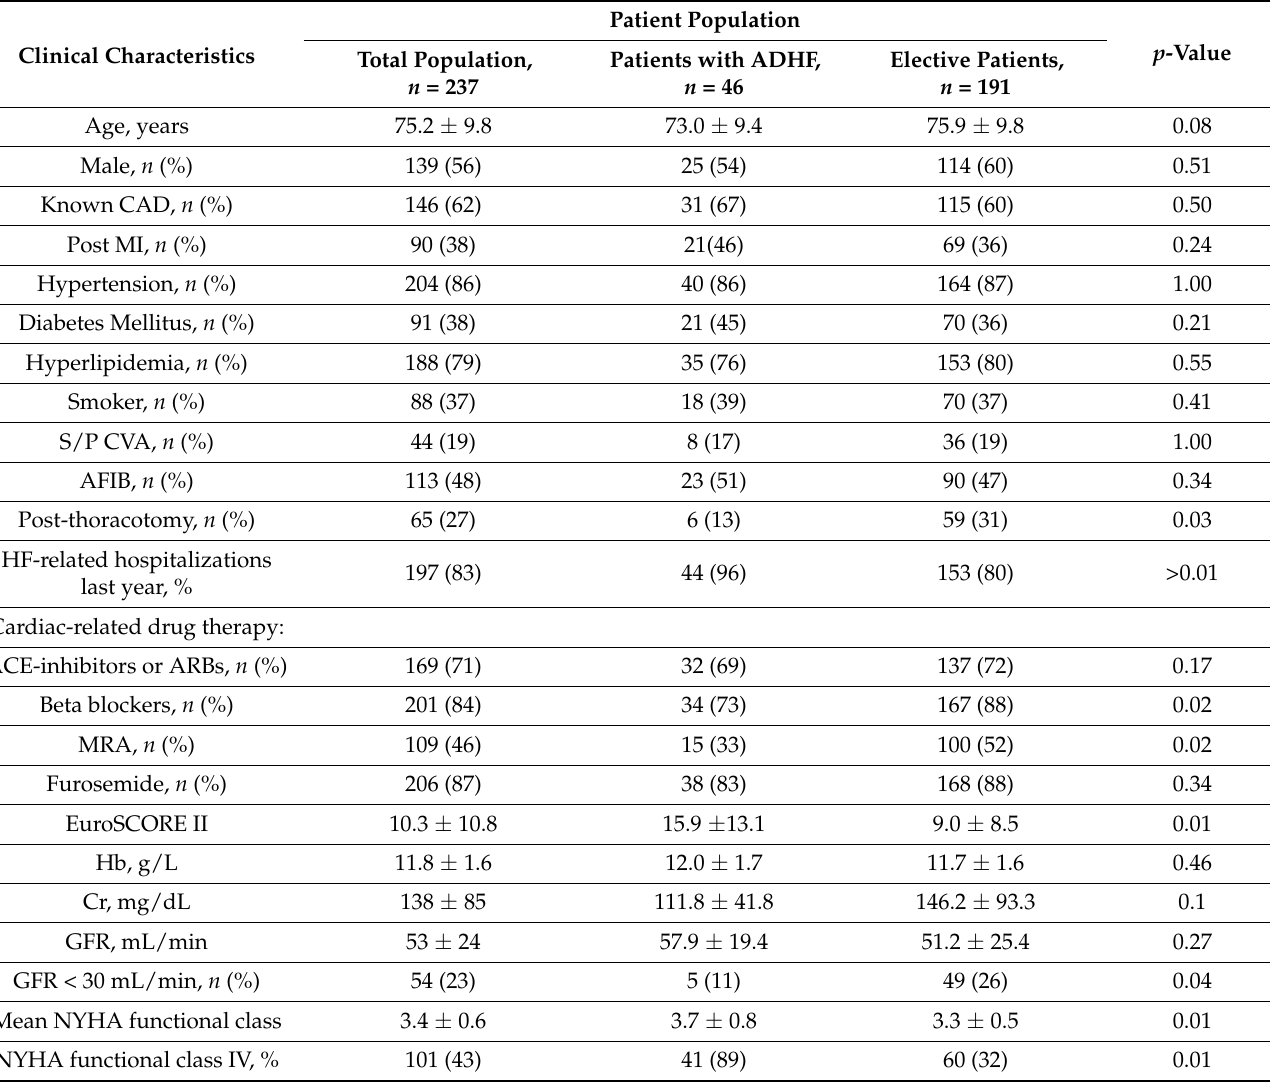
Table 1. Baseline clinical characteristics of study population before